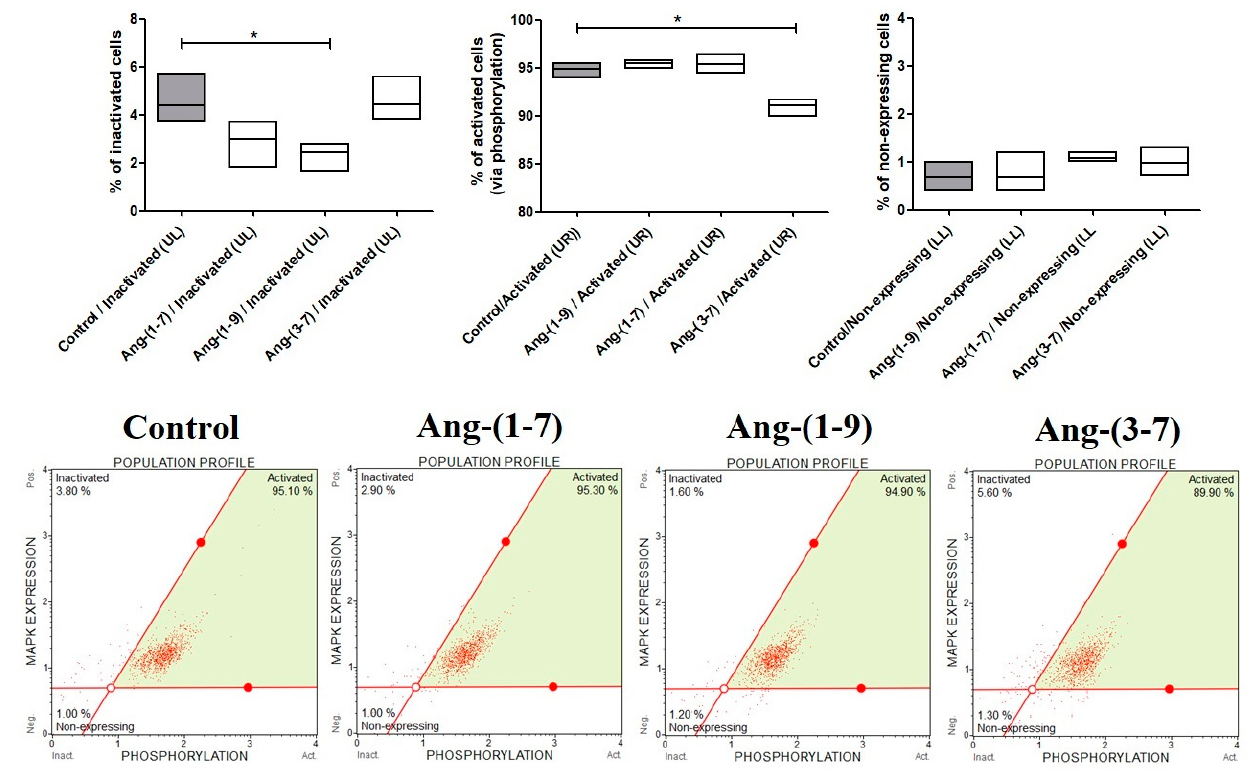
Figure 5. The Muse® MAPK Activation Dual Detection Assay results, following the incubation (48 h) of OVPA8 cells with tested angiotensins in the medium without FBS (mean ± SD; one-way ANOVA with Tukey’s test: * p < 0.05).